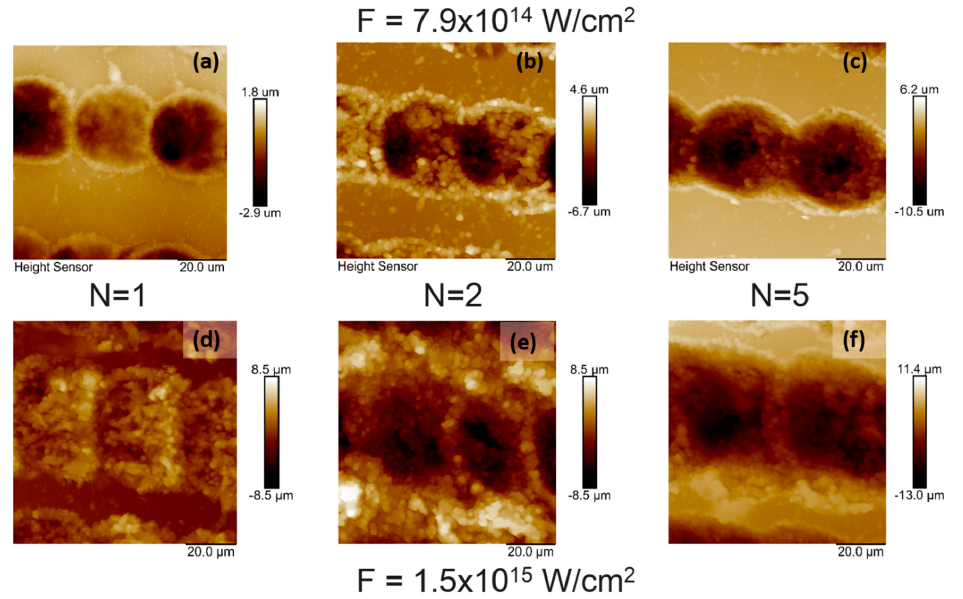
Figure 3. Atomic force microscopy (AFM) topography images of chitosan thin film over an area of 20 × 20 µm 2 irradiated with fs laser at λ = 800 nm, τ = 130 fs at different I and N : ( a ) I = 7.9 × 10 14 W/cm 2 , N = 1, R rms = 0.780 µm; ( b ) I = 7.9 × 10 14 W/cm 2 , N = 2, R rms = 2. 266 µm; ( c ) I = 7.9 × 10 14 W/cm 2 , N = 5, R rms = 2. 430 µm; ( d ) I = 1.5 × 10 15 W/cm 2 , N = 1, R rms = 1.617 µm; ( e ) I = 1.5 × 10 15 W/cm 2 , N = 2, R rms = 2.272 µm; ( f ) I = 1.5 × 10 15 W/cm 2 , N = 5, R rms = 2.480 µm.